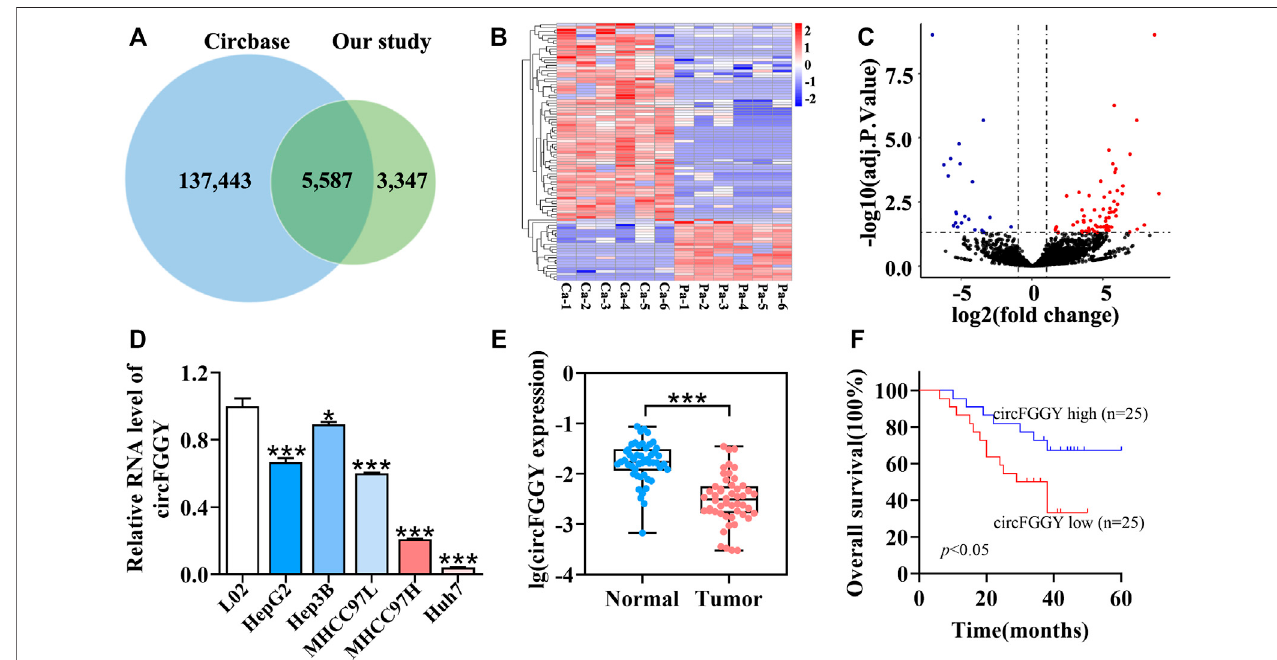
FIGURE 1 | Identi fi cation and characteristics of circFGGY. (A) Venn diagram showing the intersection between circRNAs identi fi ed in our study and circBase. (B) Clustered heatmap of the differentially expressed circRNAs in six paired HCC and adjacent normal tissues. Rows represent circRNAs while columns represent tissues. (C) Volcano plots showing the identi fi cation of circRNAs. The red color indicates upregulated genes (adj P. value < 0.05, log 2 FC > 1) and blue color indicates downregulated genes (adj P. value < 0.05, log 2 FC < -1), while black color indicates genes with no signi fi cant differences among the HCC and adjacent normal tissues.Log2FCmeansthatlog2transformationtofoldchangesofcircRNAexpressionbetweenHCCtissuesandadjacentnormaltissues. (D) qRT-PCRcomparingthe expression of circFGGY in various HCC cell lines and the normal liver cell line L02. One-Way ANOVA was used. Data are represented as mean ± SD, n = 3. Comparing withLO2, *: p < 0.05; ***: p < 0.001. (E) AnalysisofRNAexpression ofcircFGGYinthe50paired HCC andadjacent normaltissuesusingqRT-PCR.Wilcoxonmatched- pairs signedranktestwasused.Datarepresentedasmedian (Min,Max), n =50.***: p < 0.001. (F) Kaplan-MeieranalysisoftheassociationofcircFGGYexpressionand the OS of HCC patients after hepatectomy. Log-rank test was used, n = 50.